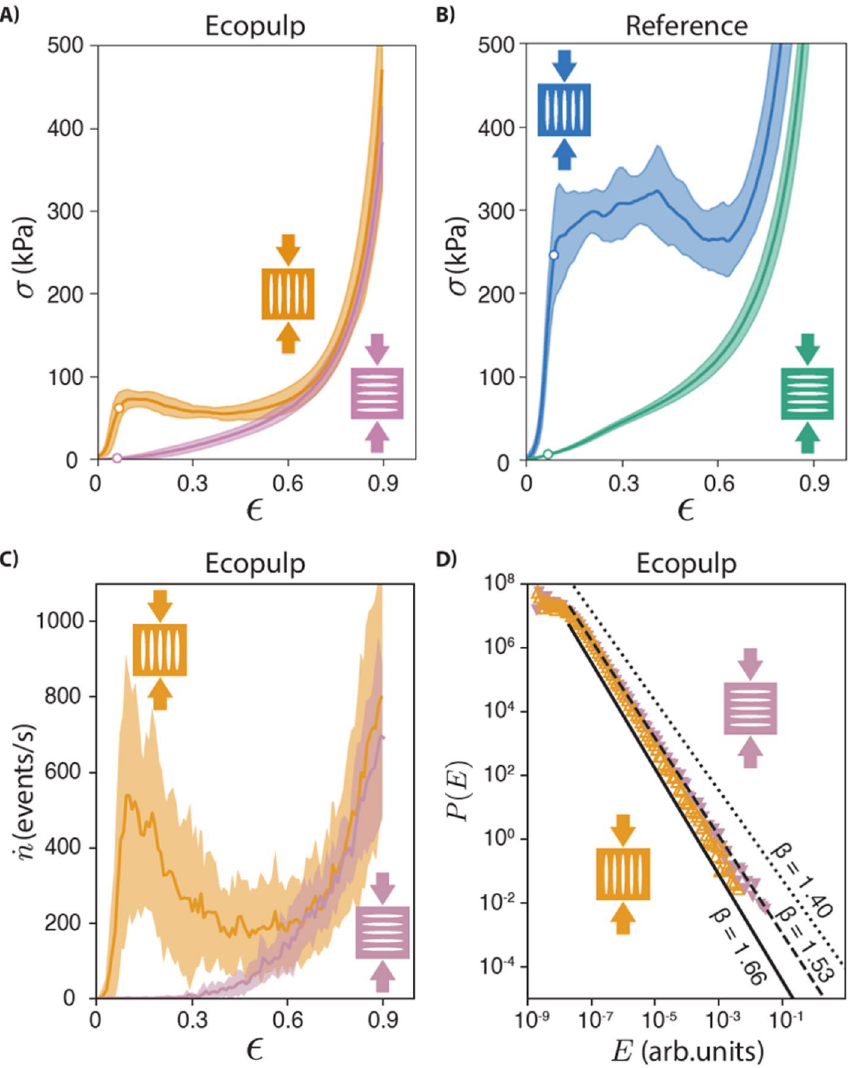
Figure 3. The mechanical properties of “Foamwood” and the complexity of deformation measured in acoustic emission by “foamquakes”. The compression data from Ecopulp fibers along the rod (yellow) and across the rod (pink). Reference fibers are shown along the rod (blue) and across the rod (green). Lines indicate the average of multiple experiments; the surrounding shaded area indicates the standard deviation. The yield point is indicated as circles in panels A and B. The anisotropy of the foam is particularly evident in the compression strength along and parallel to the major axis of the pores in both sample types, made from ( A ) chopped Ecopulp and n indicates that the majority of pores ( B ) untreated reference fibers. ( C ) The acoustic emission (AE) event rate ˙ 10% , while the cross grain sample does not produce oriented along the grain break near the yield strain at ǫ = 30% , indicating pure elastic deformation. ( D ) The theoretical AE energy probability distribution AE until ǫ = functions have three three models (black). There is a clear difference between experiments with different pore